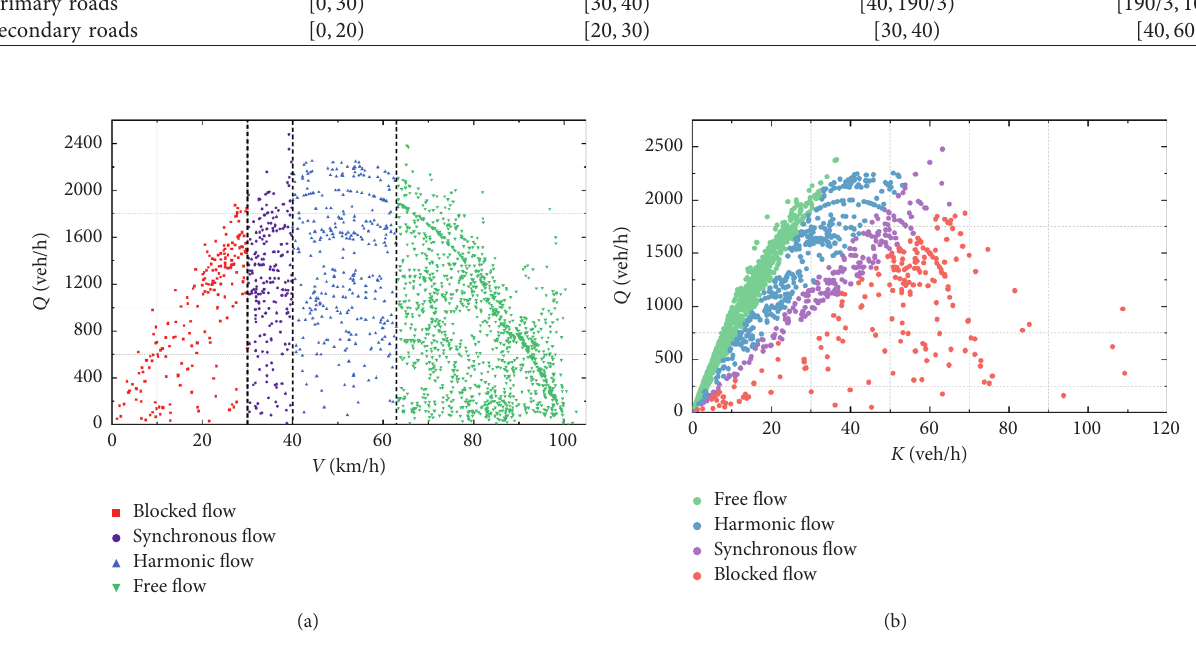
Figure 9: MFD of the overall road network: (a) Q-V curve, (b) Q-K curve. Table 3: Traffic flow prediction accuracy evaluation of NARX